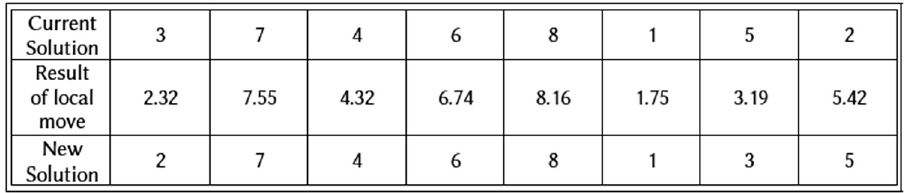
Figure 7: An example of employing the local walk on a current solution.